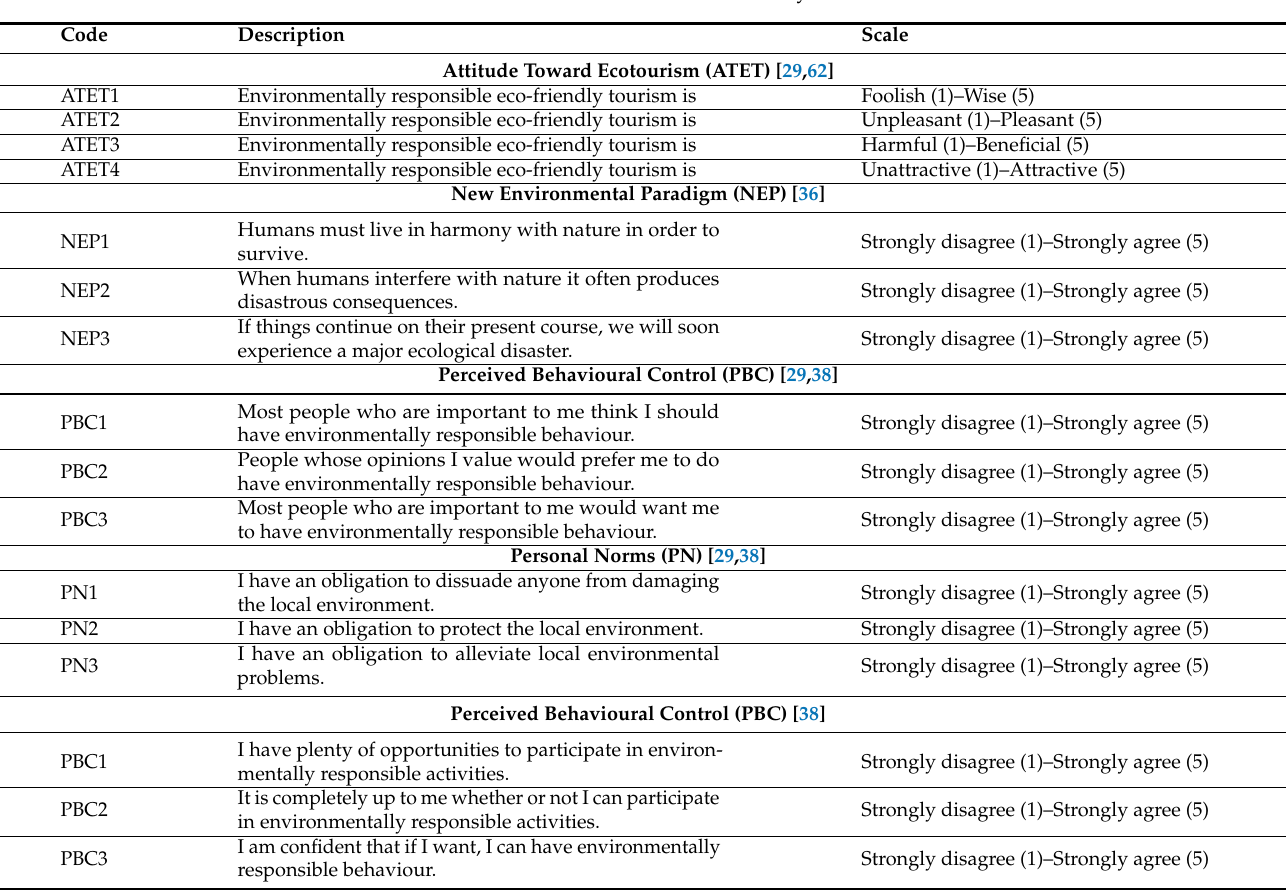
Table A1. Scales used in the